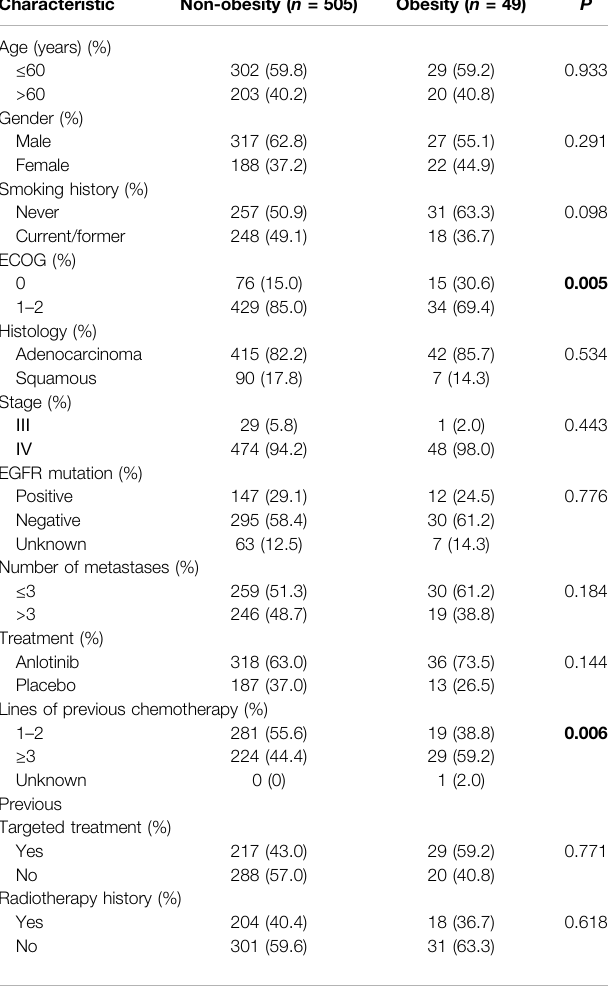
The bold values mean that the p value was considered statistically signi fi cant. Abbreviations: Eastern Cooperative Oncology Group (ECOG); epidermal growth factor receptor